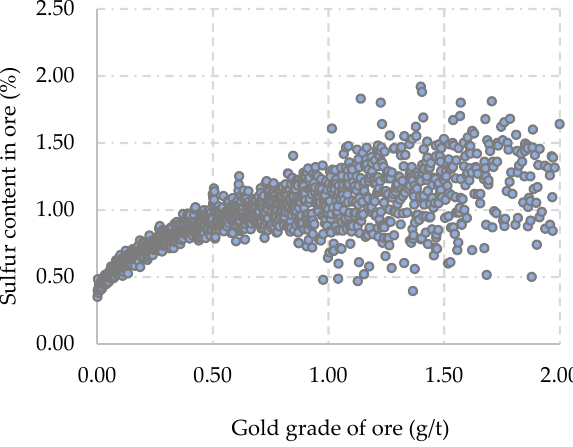
Figure 5. Scatterplot of sulphur versus gold grade. There is a mineralogical association between gold, pyrite, and arsenopyrite (gold occurring in “solid solution” or as sub-microscopic particles). From 1 g/t of gold, the relation is found to be more dispersed due to the occurrence of predominantly sulphide clusters, as shown in Figure 5.